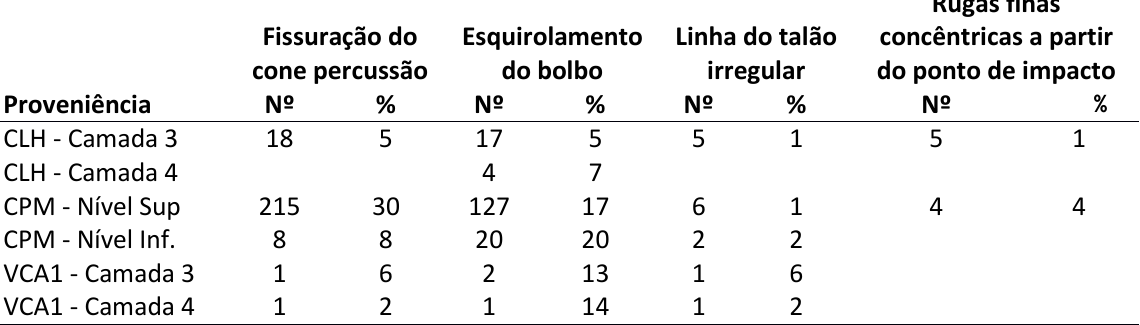
Tabela 5. Número e percentagem de peças apresentando estigmas relacionáveis com a utilização de um percutor em pedra branda: fissuração do cone de percussão, esquirolamento do bolbo, linha do talão irregular e rugas finas concêntricas a partir do ponto de impacto (Pelegrin, 2000). VCA1 - Abrigo 1 de Vale Covões; CLH - Lapa dos Coelhos; CPM I - Cabeço de Porto Marinho I. Table 5. Number and percentage of pieces presenting stigmata related to the use of a soft hammerstone: percussion cone cracking, splintering of the butt, irregular bead line and fine concentric wrinkles starting from the impact point VCA1 - Abrigo 1 de Vale. Covões; CLH - Lapa dos Coelhos; CPM I - Cabeço de Porto Marinho